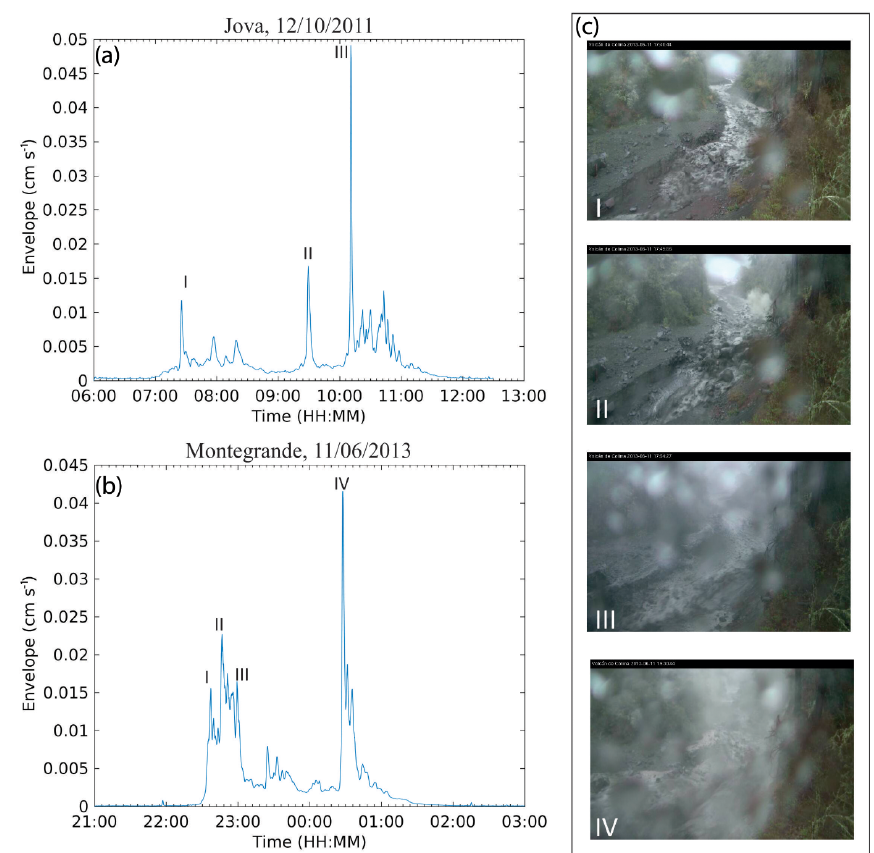
Figure 5. (a) Seismic record of the lahar triggered during the Hurricane Jova, on 12 October 2011. (b) Seismic record of the lahar triggered during the 11 June 2013 event. Main pulses are indicated with roman letters. (c) Images captured by the camera, corresponding to the main lahar pulses as indicated in panel (b)